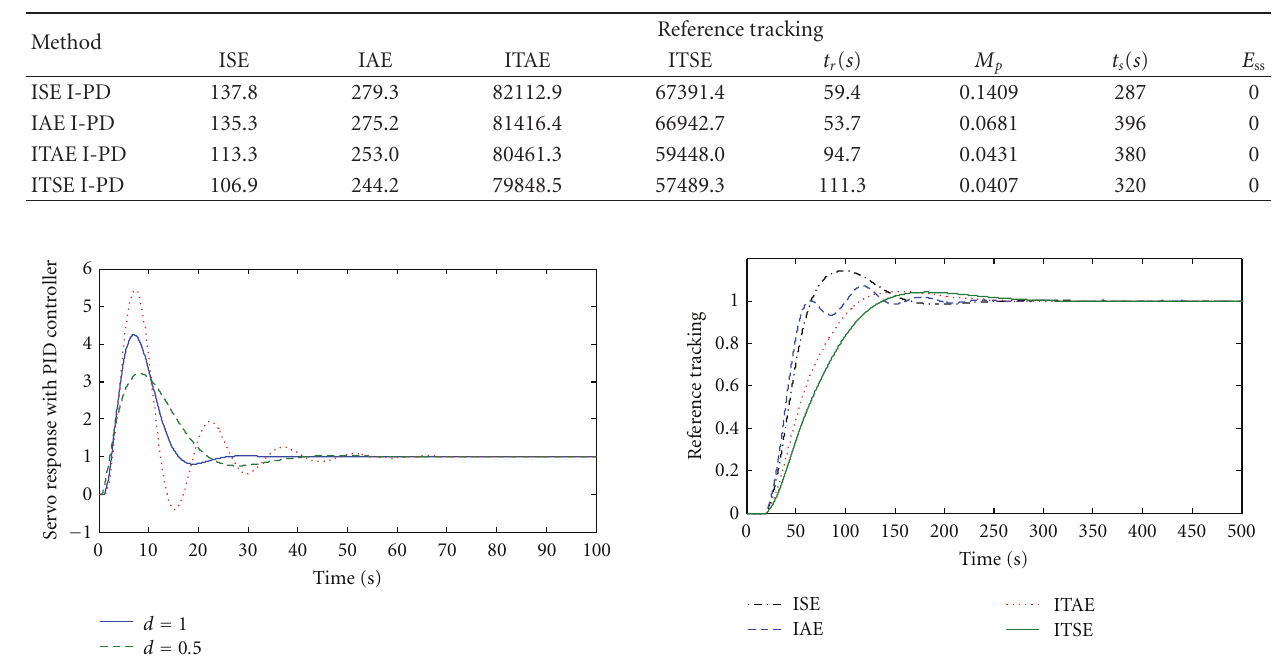
Table 8: Performance index for the CSTR model.